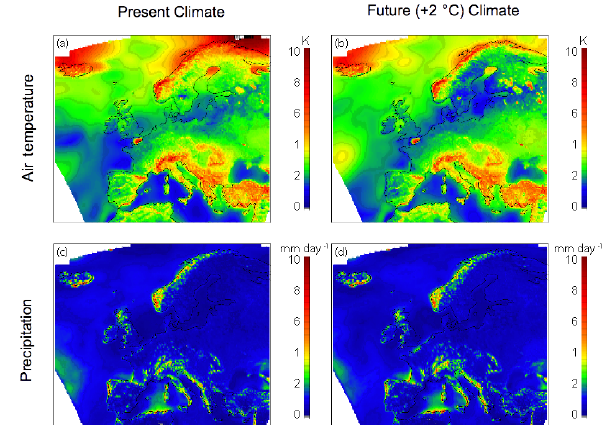
Figure 3. Ensemble spread (the difference between the minimum and the maximum from the ensemble members) of mean annual air temperature (a, b) and average precipitation (c, d) from uncorrected RCMs for present (1971–2000, a, c ) and future ( + 2 ◦ C , b, d ) Cli- mate considering RCP 4.5